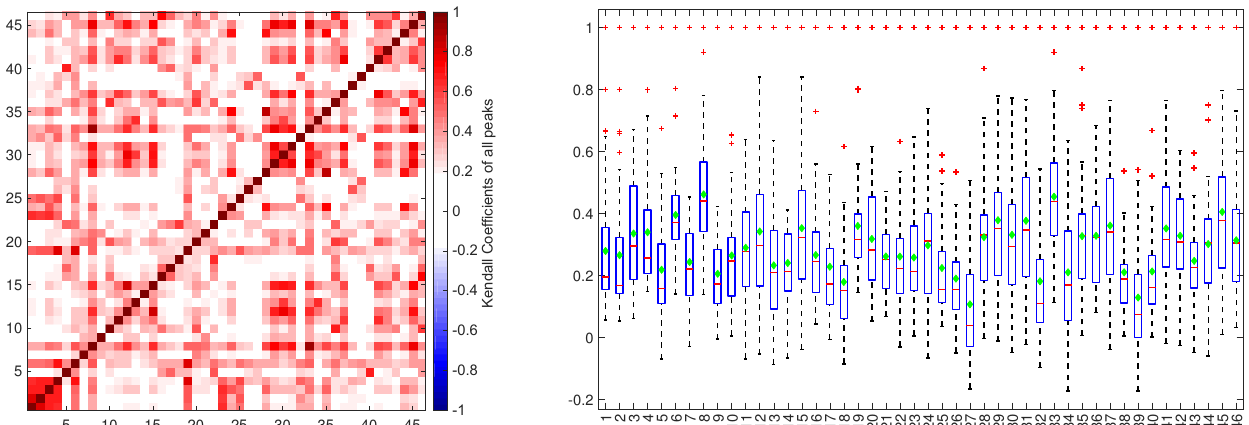
Figure 4. Kendall rank correlation among all pair set of extremes; In the box plot, red plus: outliers, central red line: median, green diamond: mean.